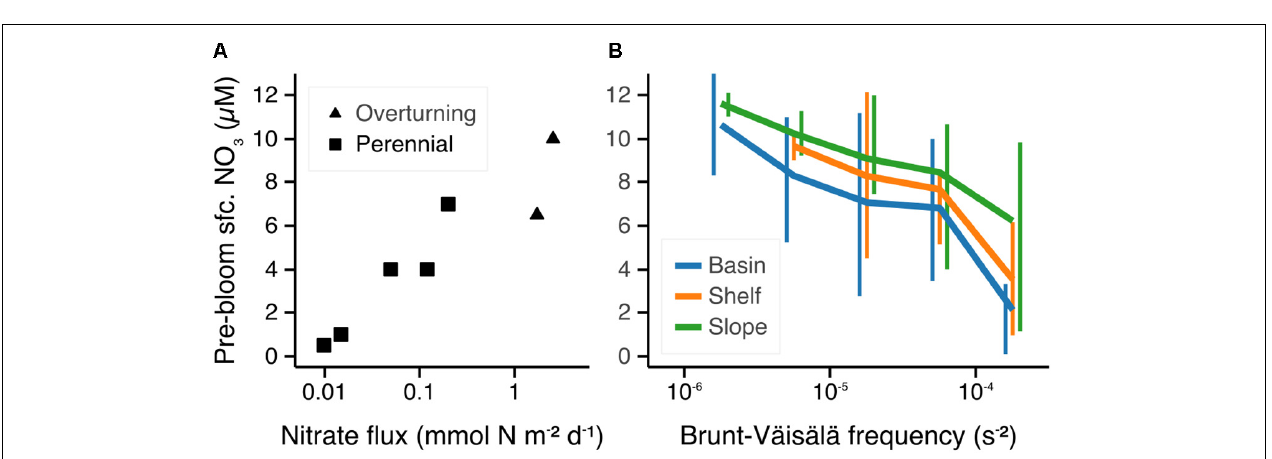
FIGURE 4 | The surface nitrate inventory dominated by variations in turbulent mixing. The annual pre-bloom surface nitrate concentration graphed as a function of (A) the vertical nitrate flux during winter and (B) the strength of water column stratification in the upper 30–60 m depth interval. The bold curves show average nitrate concentration for a given strength of stratification for either of three bathymetry types. Vertical bars (horizontally slightly offset to increase readability) indicate the standard deviation of data for each bin. Data sources: (A) nitrate flux compilation, (B) nitrate profile database.